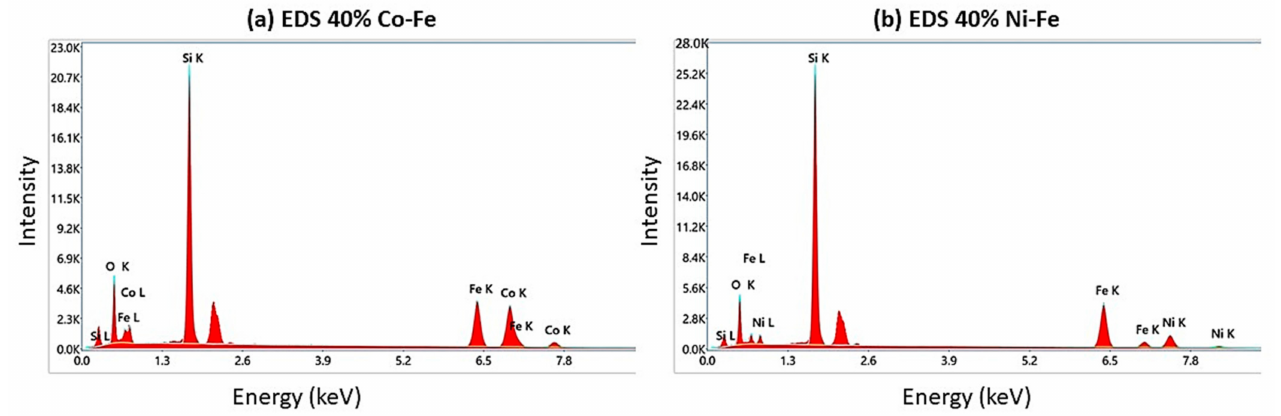
Figure 4. EDS graphs for ( a ) 40% Co-Fe MRE and ( b ) 40% Ni-Fe MRE